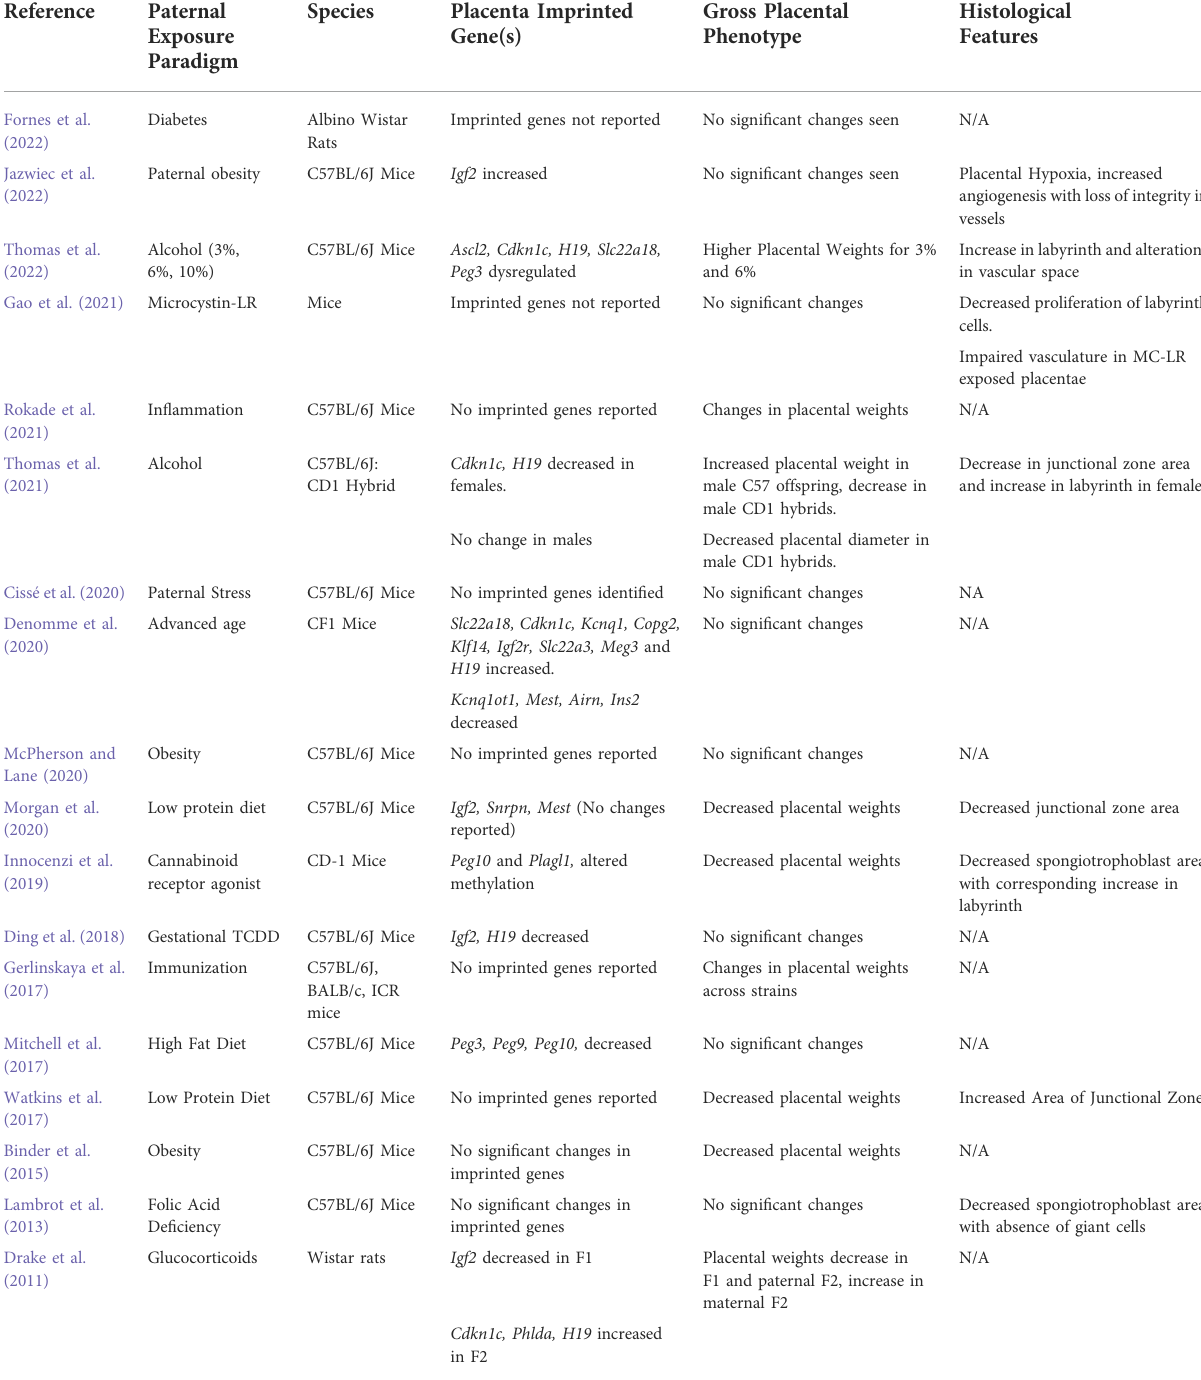
TABLE 1 Studies describing the impacts of preconception paternal exposures on offspring